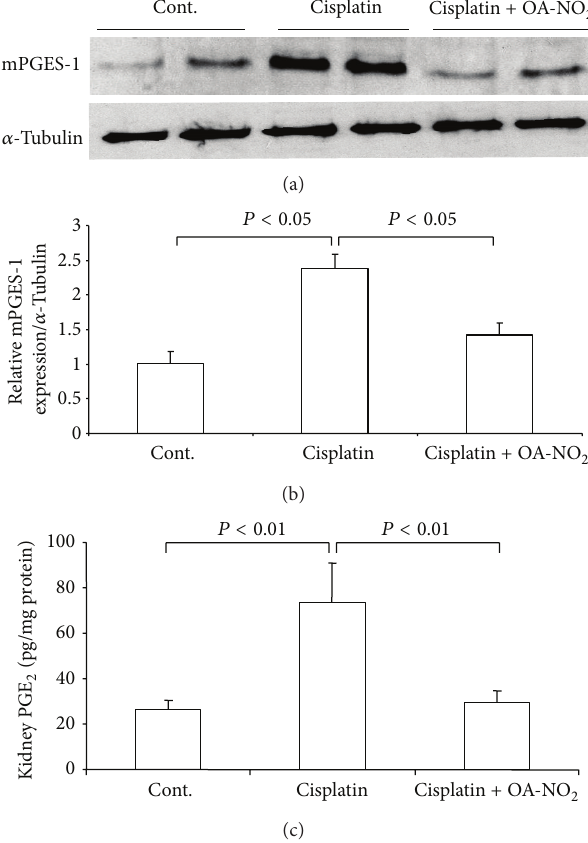
Figure 4: Renal COX-2 mRNA and protein expressions in control, cisplatin vehicle, and cisplatin + OA-NO 2 mice. (a) qRT-PCR analysis of renal COX-2 mRNA; (b) western blotting analysis of renal COX-2 protein expression; (c) densitometric value of COX- 2 protein; Cont.: 𝑁 = 6 ; cisplatin: 𝑁 = 12 ; cisplatin + OA-NO 2 : 𝑁 = 13 . Data are mean ± SE.